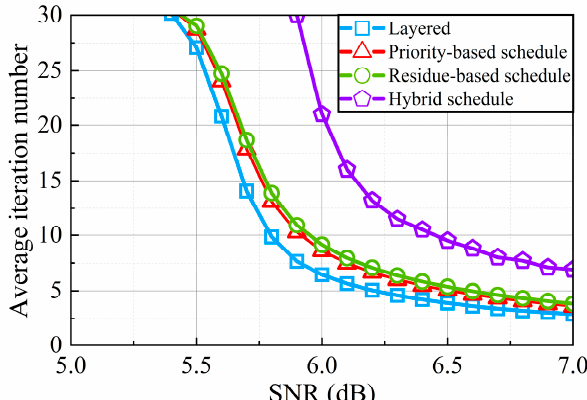
Figure 8. Average iteration number necessary for successful decoding for 5G NR (code rate = 22/27) compared with the result of the hybrid schedule.